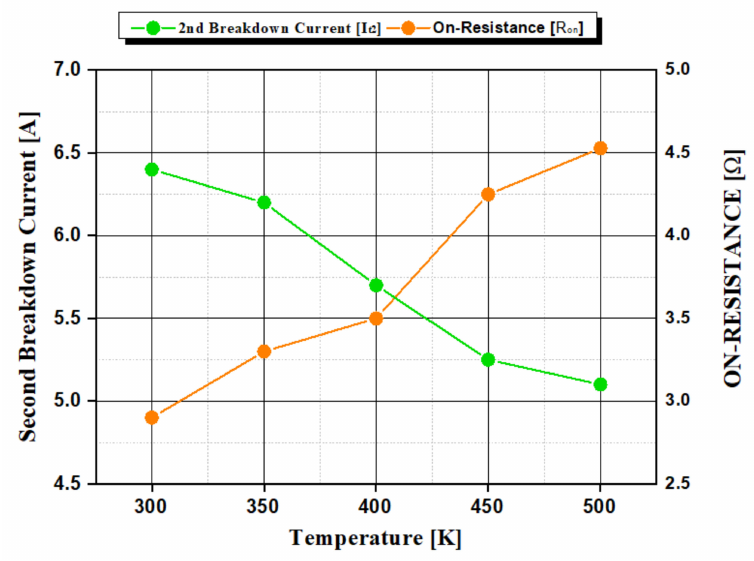
Figure 19. Secondary trigger current and on-resistance (300 to 500